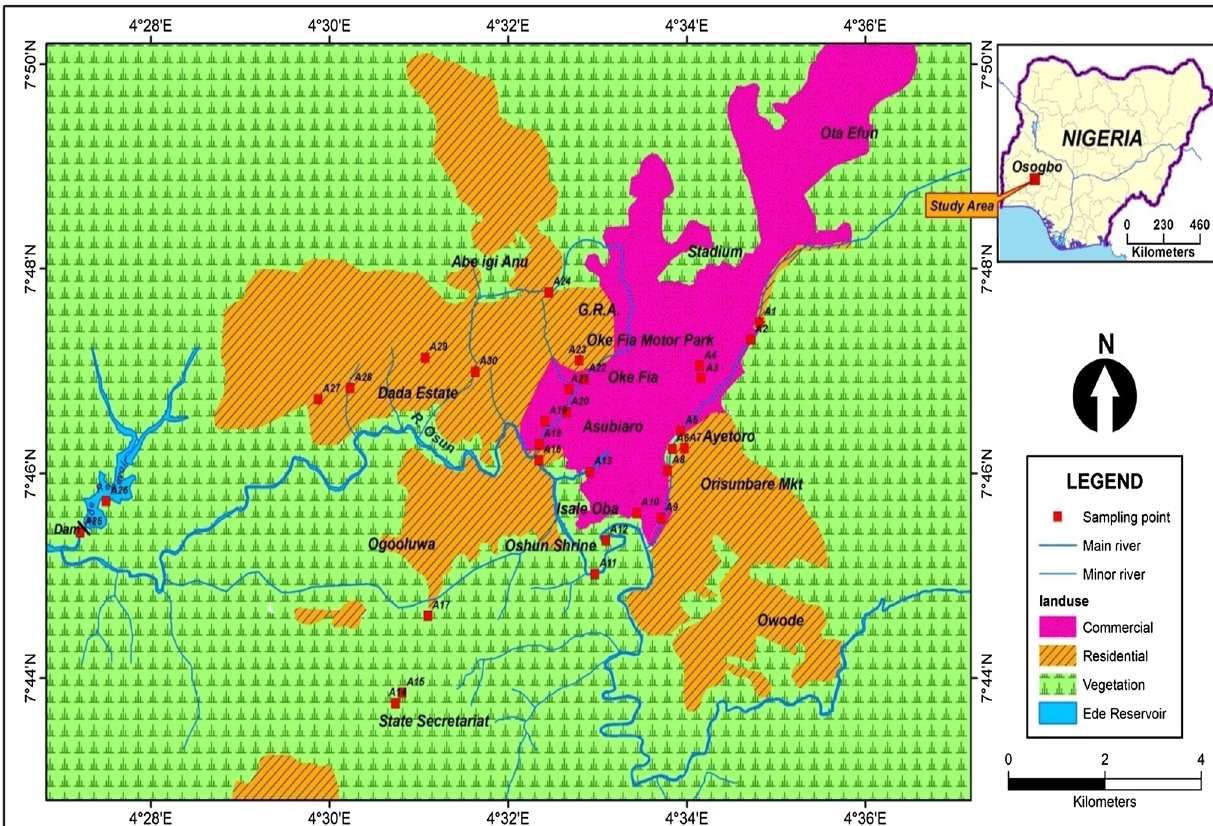
Fig. 3 Map of Landuse types in Osogbo metropolis